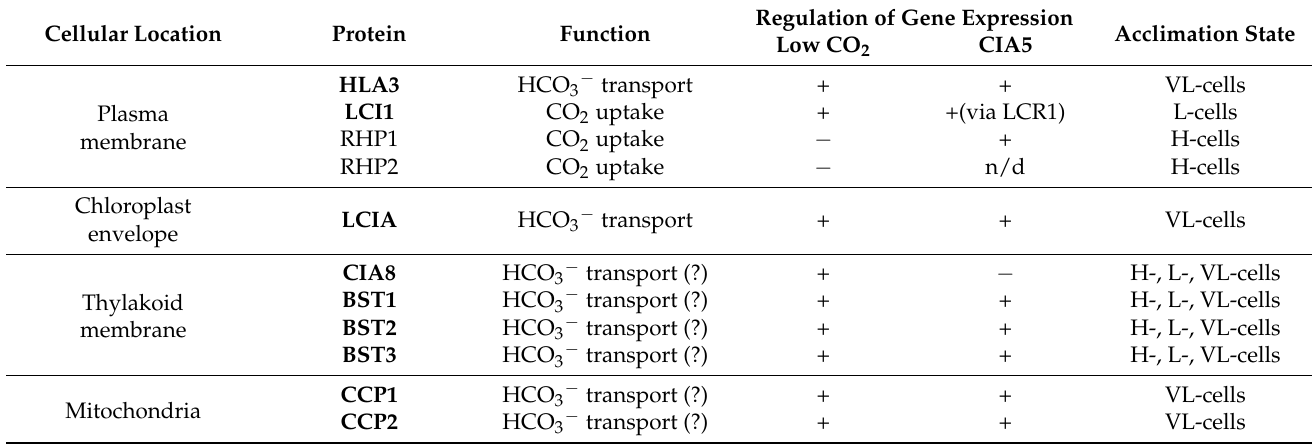
Table 1. Confirmed and potential C i transport systems in C. reinhardtii .